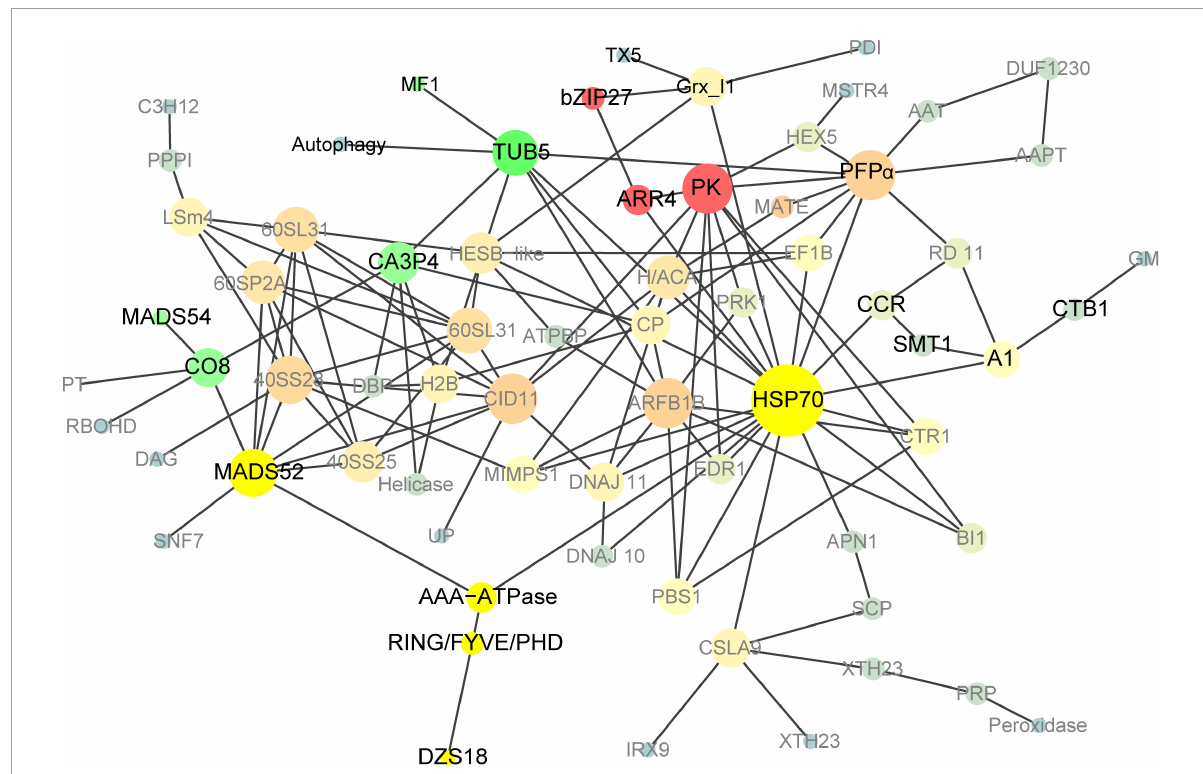
FIGURE7 Co-expression network analyses of DEGs in pRbcS:AtSAT1-pRbcS:EcPAPR 18 DAP endosperm. Cycle nodes represent genes; the size of nodes represents the power of the interrelation among the nodes, and edges between two nodes represent interactions between genes. The more edges of a gene, the more genes are connected to it, and the more central role it has within the network.